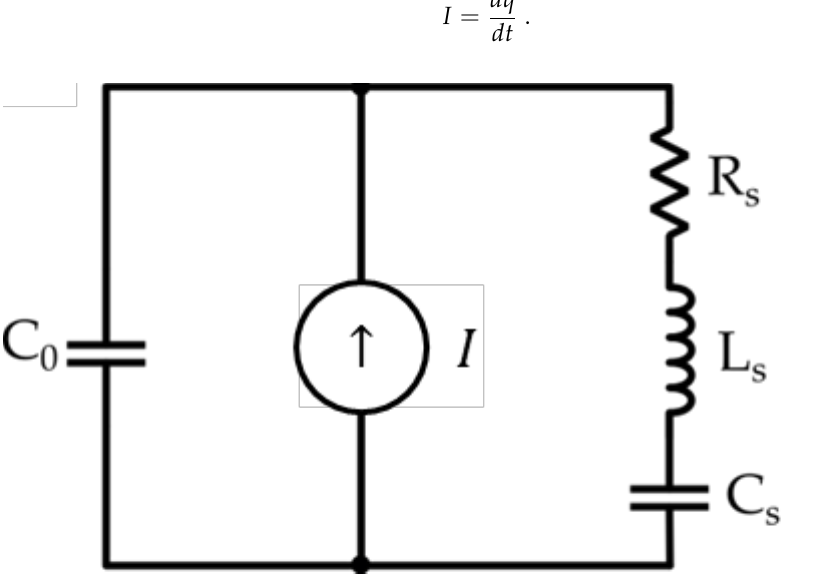
Figure 14. Equivalent circuit of a piezoelectric transducer in reception. The current 𝐼 is the derivative of the charge that develops in response to an applied force.